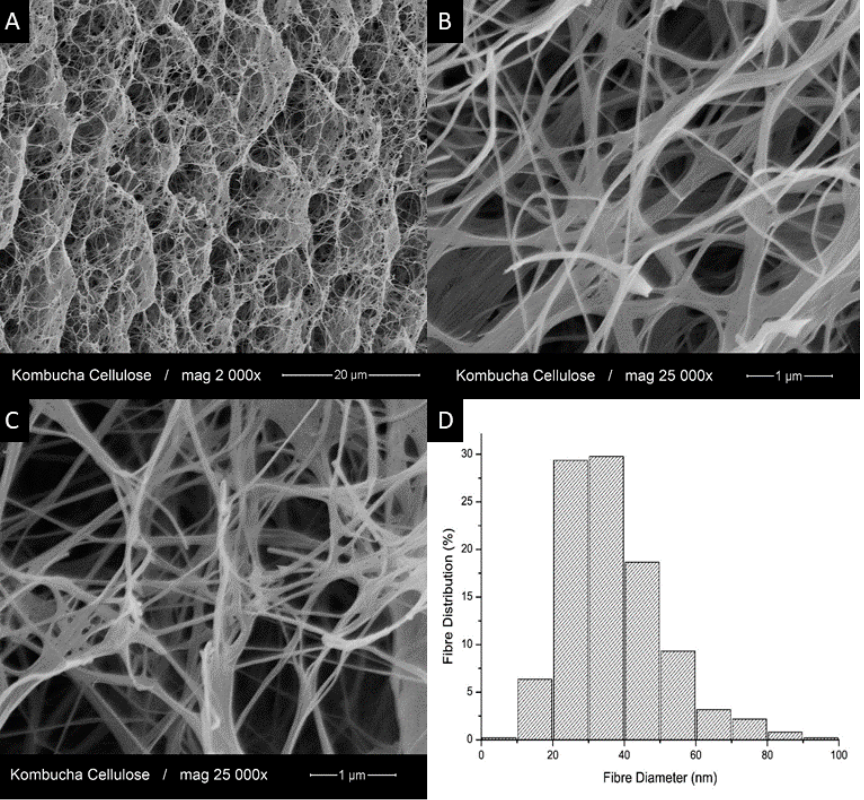
Figure 2. Scanning electron microscopy (SEM) micrographs of the KBC showing ( A ) the general structure of the KBC nanofiber network; ( B , C ) its magnified structure details, and ( D ) size distribution of the KBC nanofibers present in the network (width).